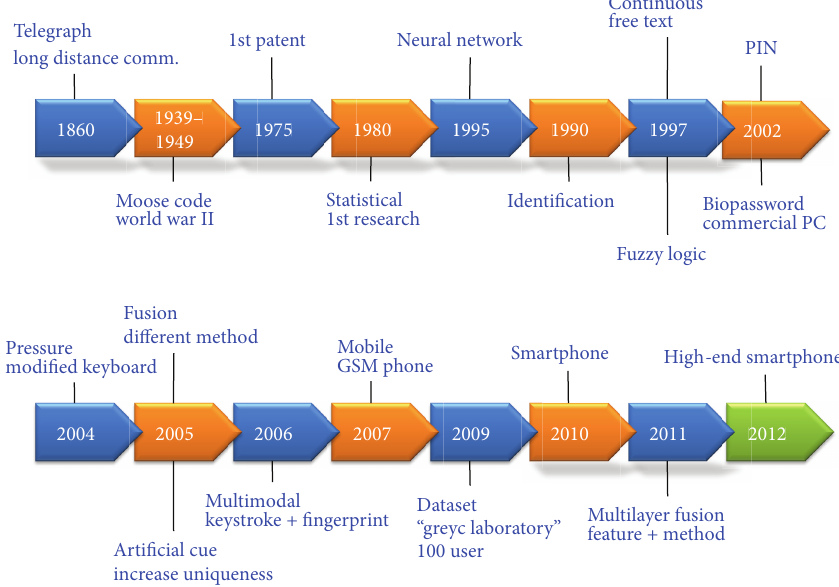
Figure 2: A general timeline on the overview of keystroke research work